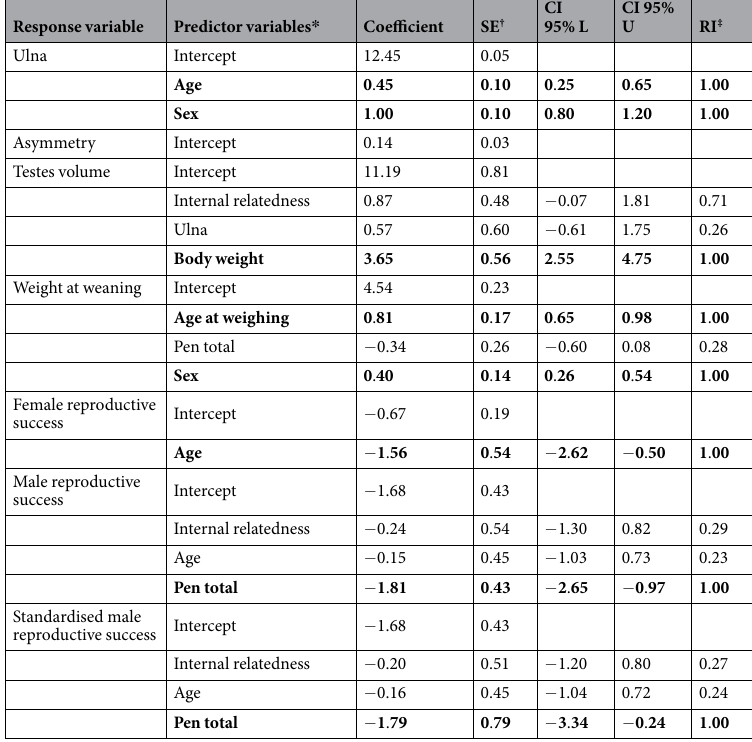
Table 3. Summary of standardised predictors and their relative importance after averaging of top models (all models within 2AIC C ) (see methods for details on predictors in each global model). * Standardised predictors to a mean of 0 and a standard deviation of 0.5; all bold predictor variables have confidence intervals that do not include zero. † SE; standard error. ‡ RI; relative importance.